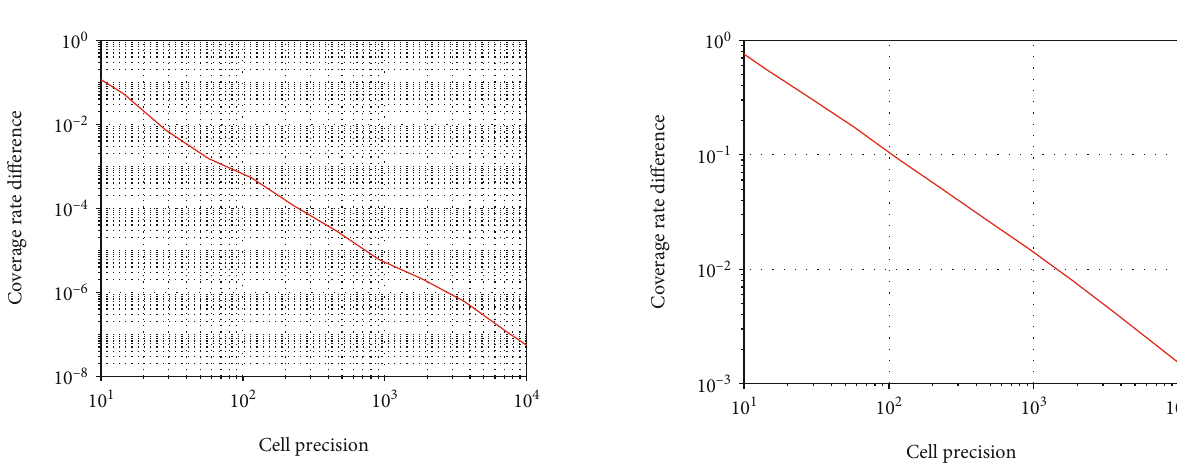
Figure 9: Comparison of the cell counts from two algorithms with di ff erent precisions for target-2.